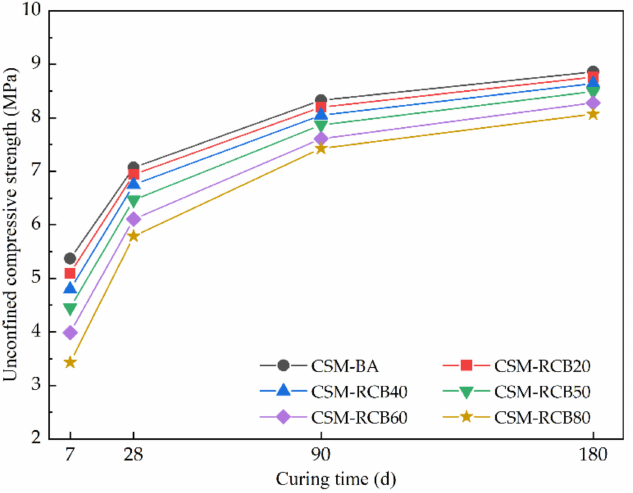
Figure 6. The unconfined compressive strength of CSM with different curing times.